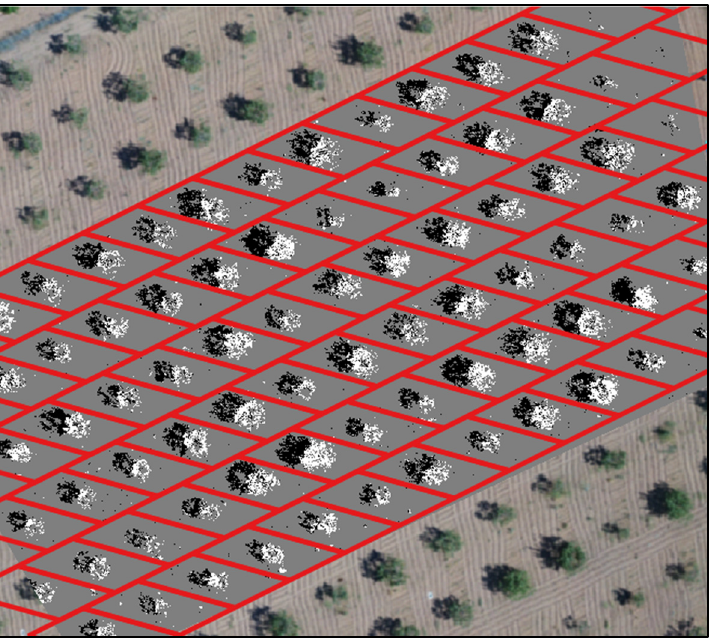
Figure 9. Grid generated using the planting pattern and solar azimuth angles (red polygons) to mask the reclassified image (background) to identify each tree and to calculate the statistics of each plant.